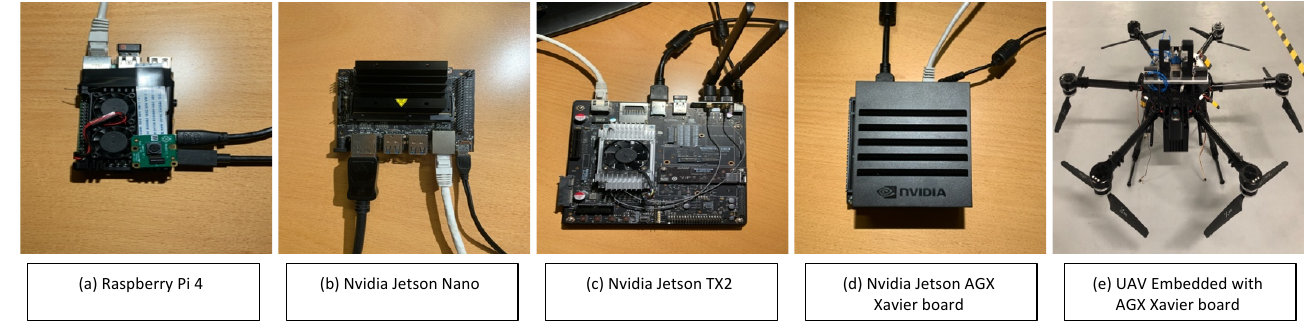
Figure 9. Single-board hardware for UAVs to run the real-time autonomous algorithm. From left to right, ( a ) Raspberry Pi 4, ( b ) Nvidia Jetson Nano, ( c ) Nvidia Jetson TX2, ( d ) Nvidia AGX Xavier, and ( e ) UAV embedded with the AGX Xavier